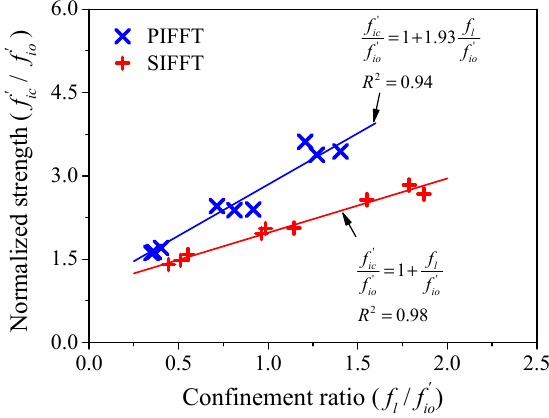
Figure 17. Regression of the compressive strength of confined ice.